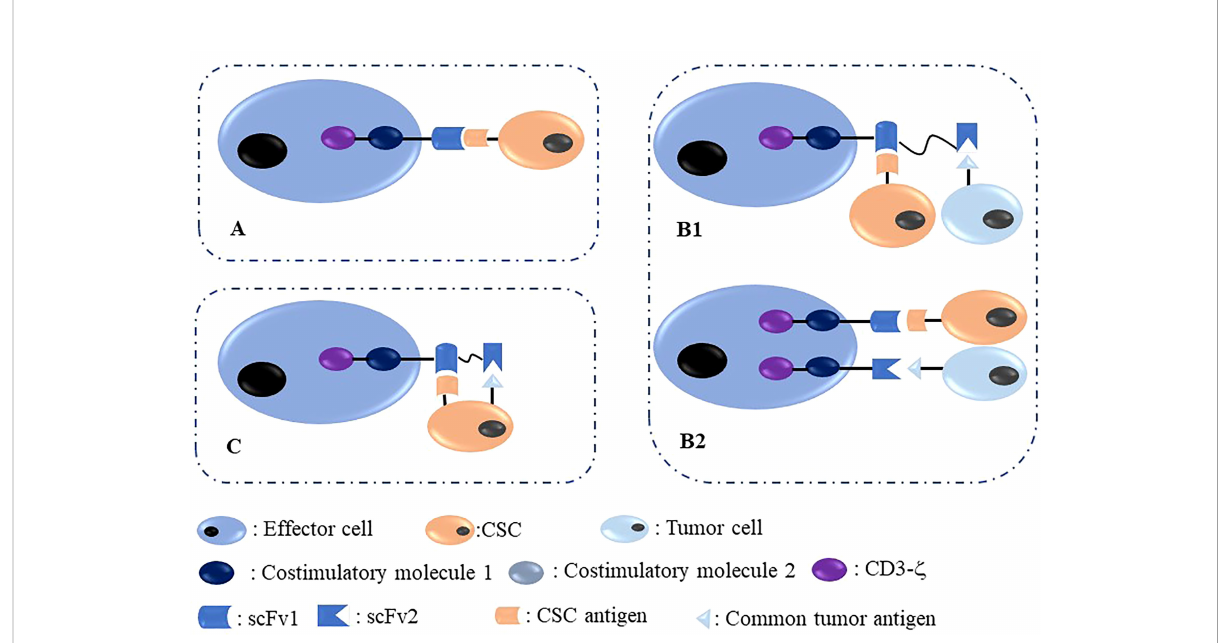
FIGURE 2 Different methods to target CSC with immune effector cells modi fi ed with CAR. (A) One target CAR-effector cell targeting a CSC antigen located on CSCs; (B) Dual-target CAR-effector cell targeting two different antigens, including one common tumor antigen and one CSC antigen located on common tumor cells and CSCs, respectively. (C) Dual-target CAR-effector cell targeting two different antigens, including one common tumor antigen and one CSC antigen located on one CSC simultaneously.